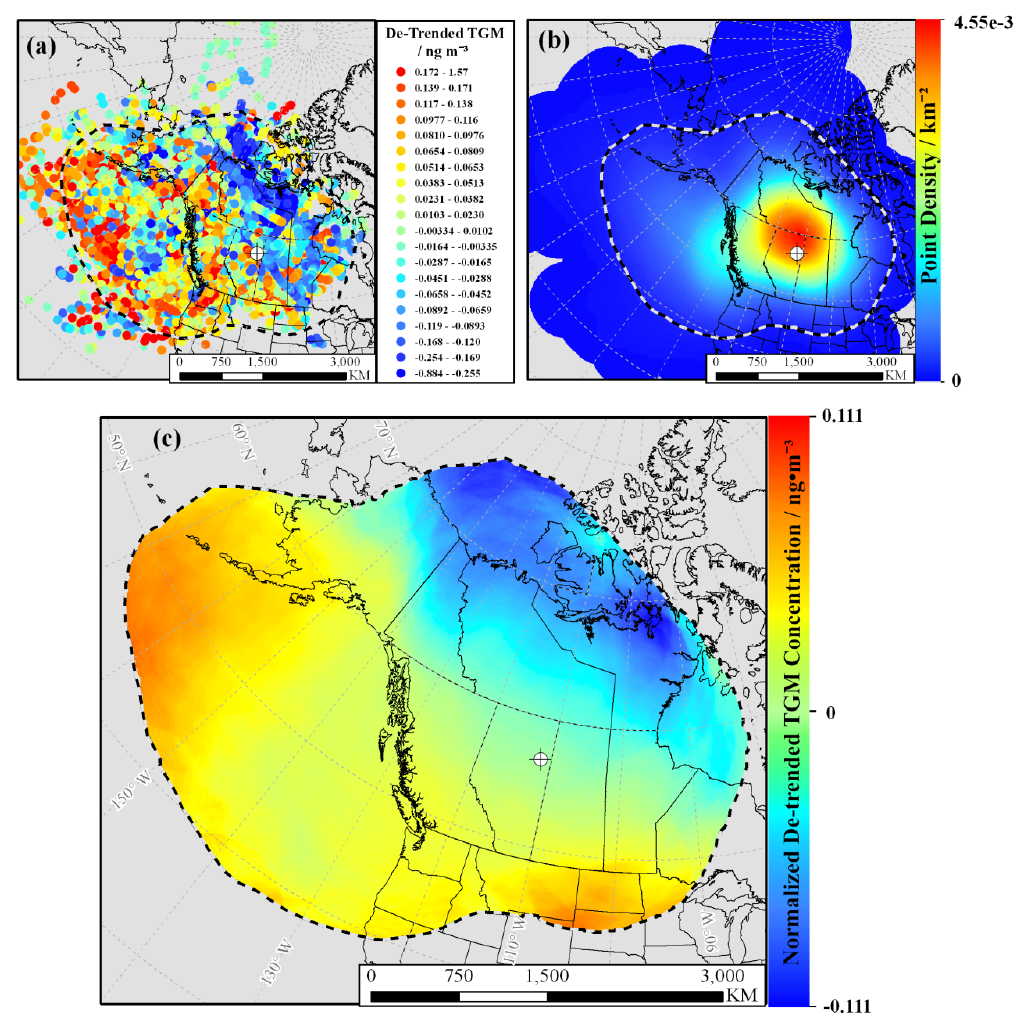
Figure 5. HYSPLIT 72-hour back trajectory analysis. Panel ( a ) shows all back trajectory starting points colour-coded to the corresponding de-trended/seasonally adjusted TGM concentrations; panel ( b ) shows the point density of back trajectory starting points; panel ( c ) shows the normalized de-trended/seasonally adjusted TGM concentrations as described in the text. Dashed lines indicate the boundary limits of the analysis as described in the text; grey areas contained insufficient or no back trajectory starting points. Fort McMurray is indicated in northern Alberta with the cross-hair symbol. Data observed with forest fire smoke were excluded from this